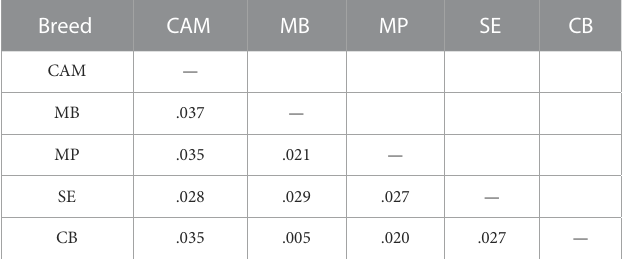
TABLE 2 Pairwise-breed estimates of genomic differentiation (F ST ) among Portuguese sheep. Breed acronyms are shown in Table 1.